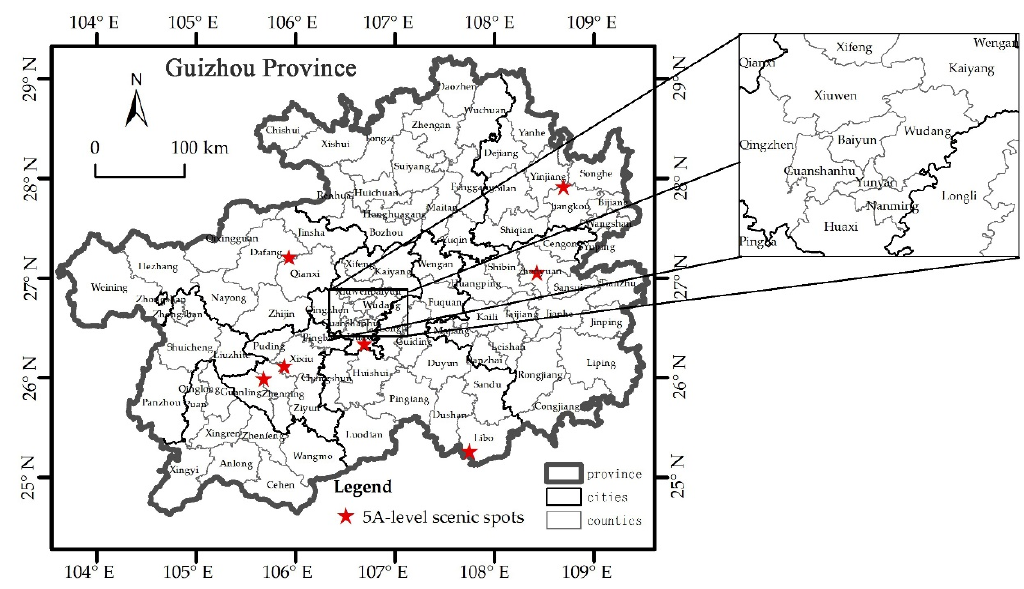
Figure 1. Map of the counties located in Guizhou Province.